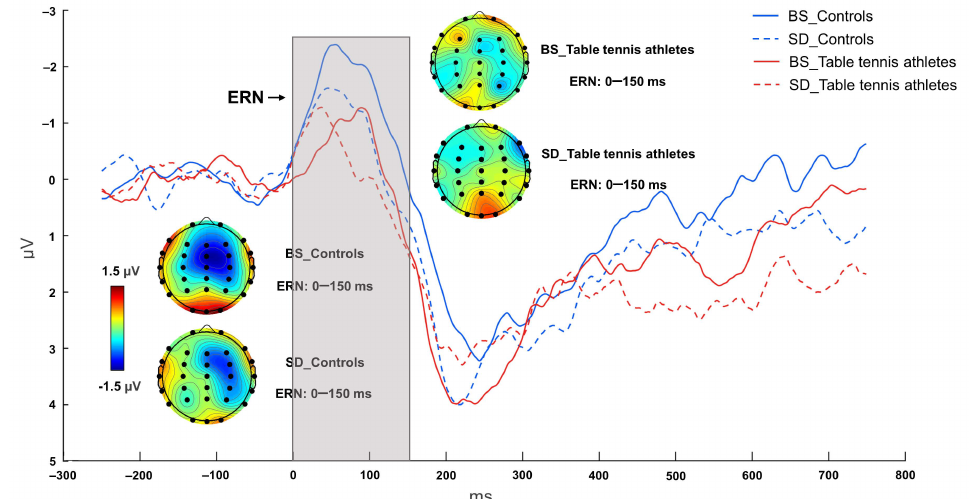
Figure 6. Grand mean ERP amplitude of table tennis athletes and controls on ERN in baseline state (BS) and 36 h sleep deprivation (SD) conditions. The data from FCz. The topographies correspond to average activity in the time windows (0–150 ms, indicated by the gray bar) around the local